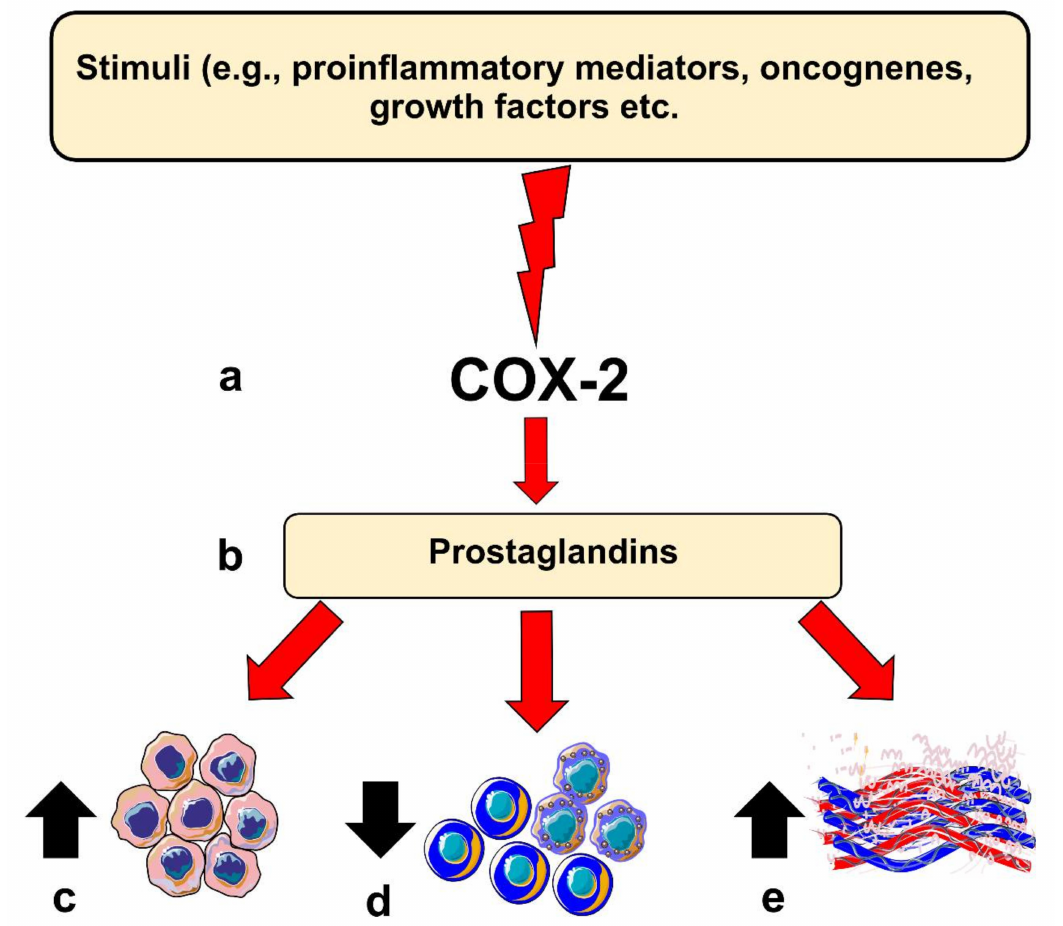
Figure 1. Role of Cyclooxygenase-2 (COX-2) in head and neck carcinogenesis. ( a ) Inflammatory stimuli, oncogenes or other factors can induce COX-2 expression in epithelial cells; ( b ) this results in the production of prostaglandins which can influence various protumorigenic processes, such as ( c ) enhancing anti-apoptotic response, ( d ) suppression of immune cell response, or ( e ) inducing angiogenesis in the host